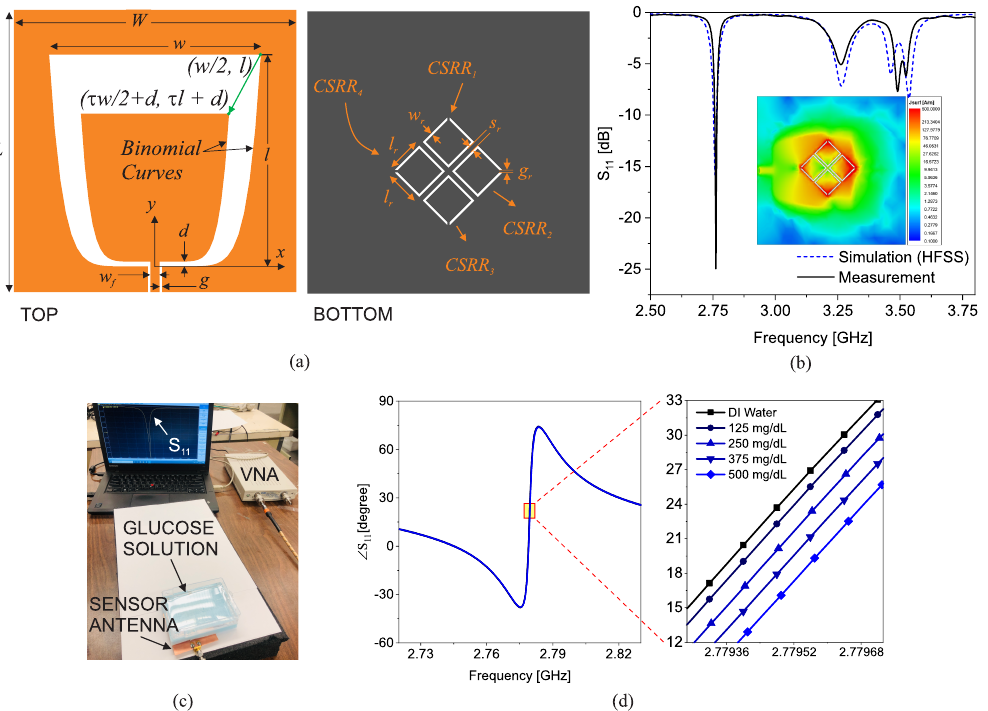
Figure 14. Structure of the fabricated sensor antenna. ( a ) Schematic of sensor antenna, l = w = 45, N = 8, τ = 0.7, d = 1, w f = 2, W = L = 60, l r = 7.8, s r = 1, g = g r = w r = 0.5 (all lengths are in (mm)); ( b ) comparison between simulated and measured | S 11 | with inset simulated surface current density at 2.78 GHz; ( c ) measurement setup; and ( d ) the phase response for various glucose concentrations. Reprinted with permission from Ref.